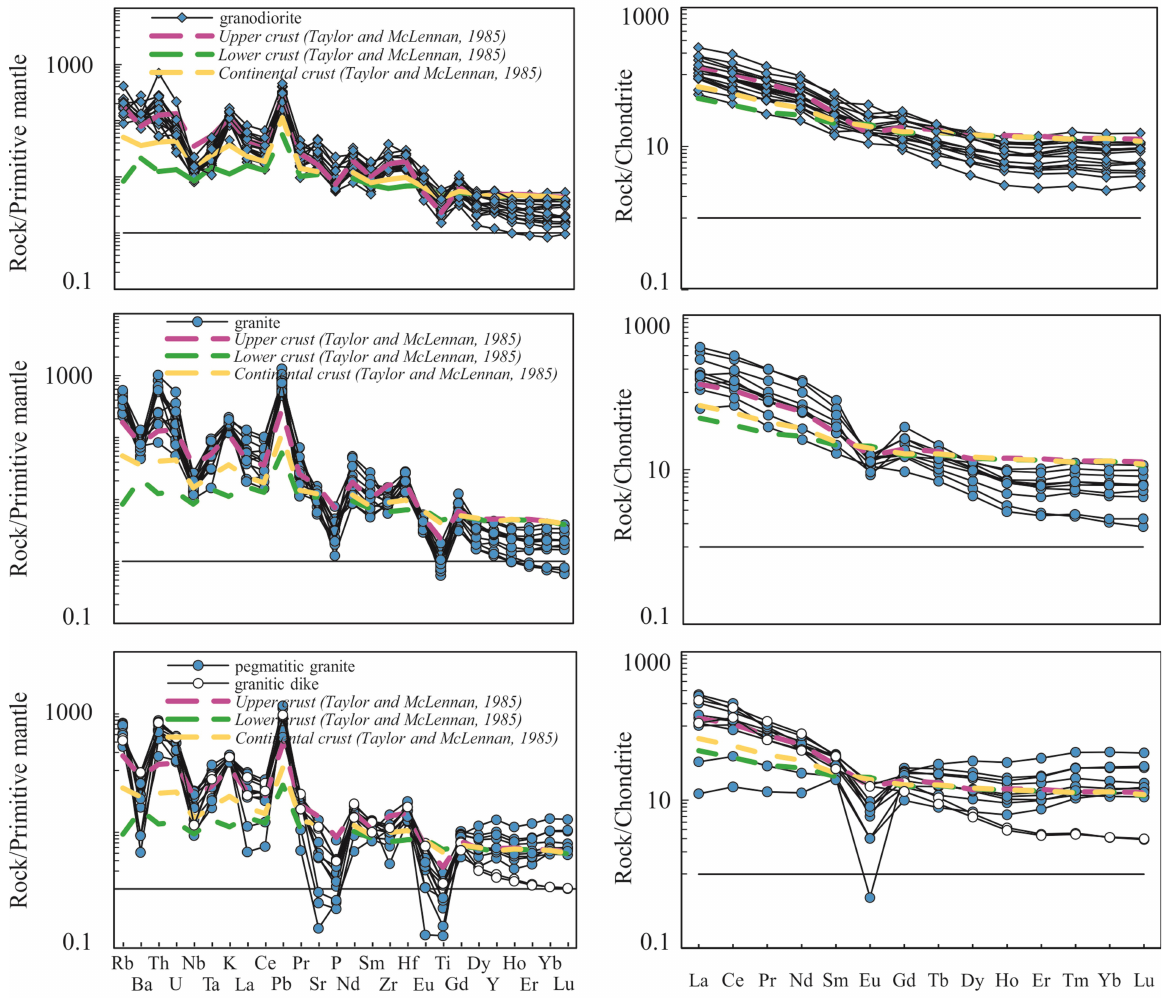
Fig. 8. Primitive-mantle-normalized multi-element and chondrite-normalized REE diagrams showing variations in the compositions of granitoids from the Khangai area. Normalizing values are from Sun and McDonough